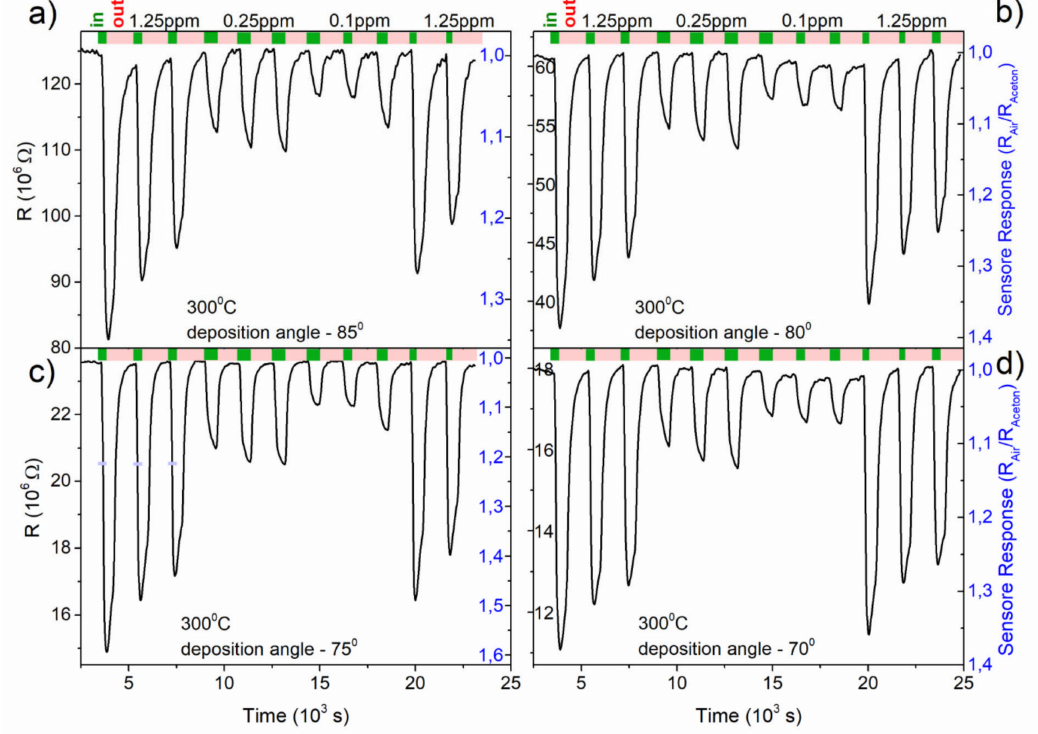
Figure 10. Resistance characteristics measured at 300 ◦ C of WO 3 gas sensor for di ff erent acetone concentrations and di ff erent tilting deposition angle ( a ) 85 ◦ , ( b ) 80 ◦ , ( c ) 75 ◦ , and ( d ) 70 ◦